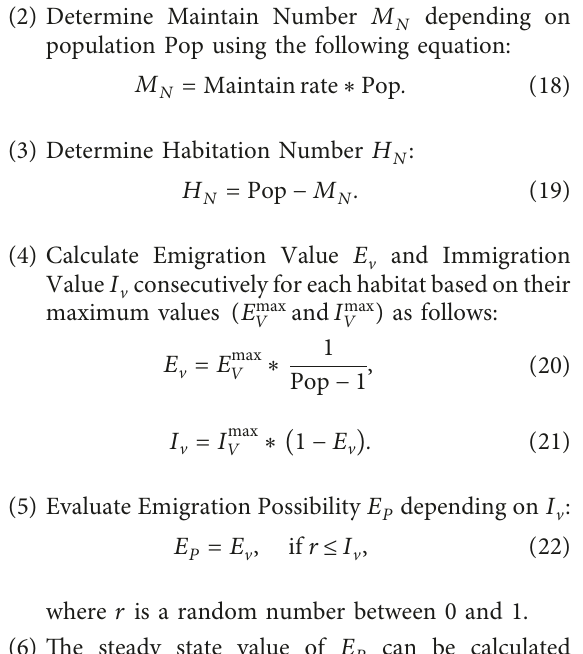
Table 2: Standard capacitor size and costs. Q c (kVAr)